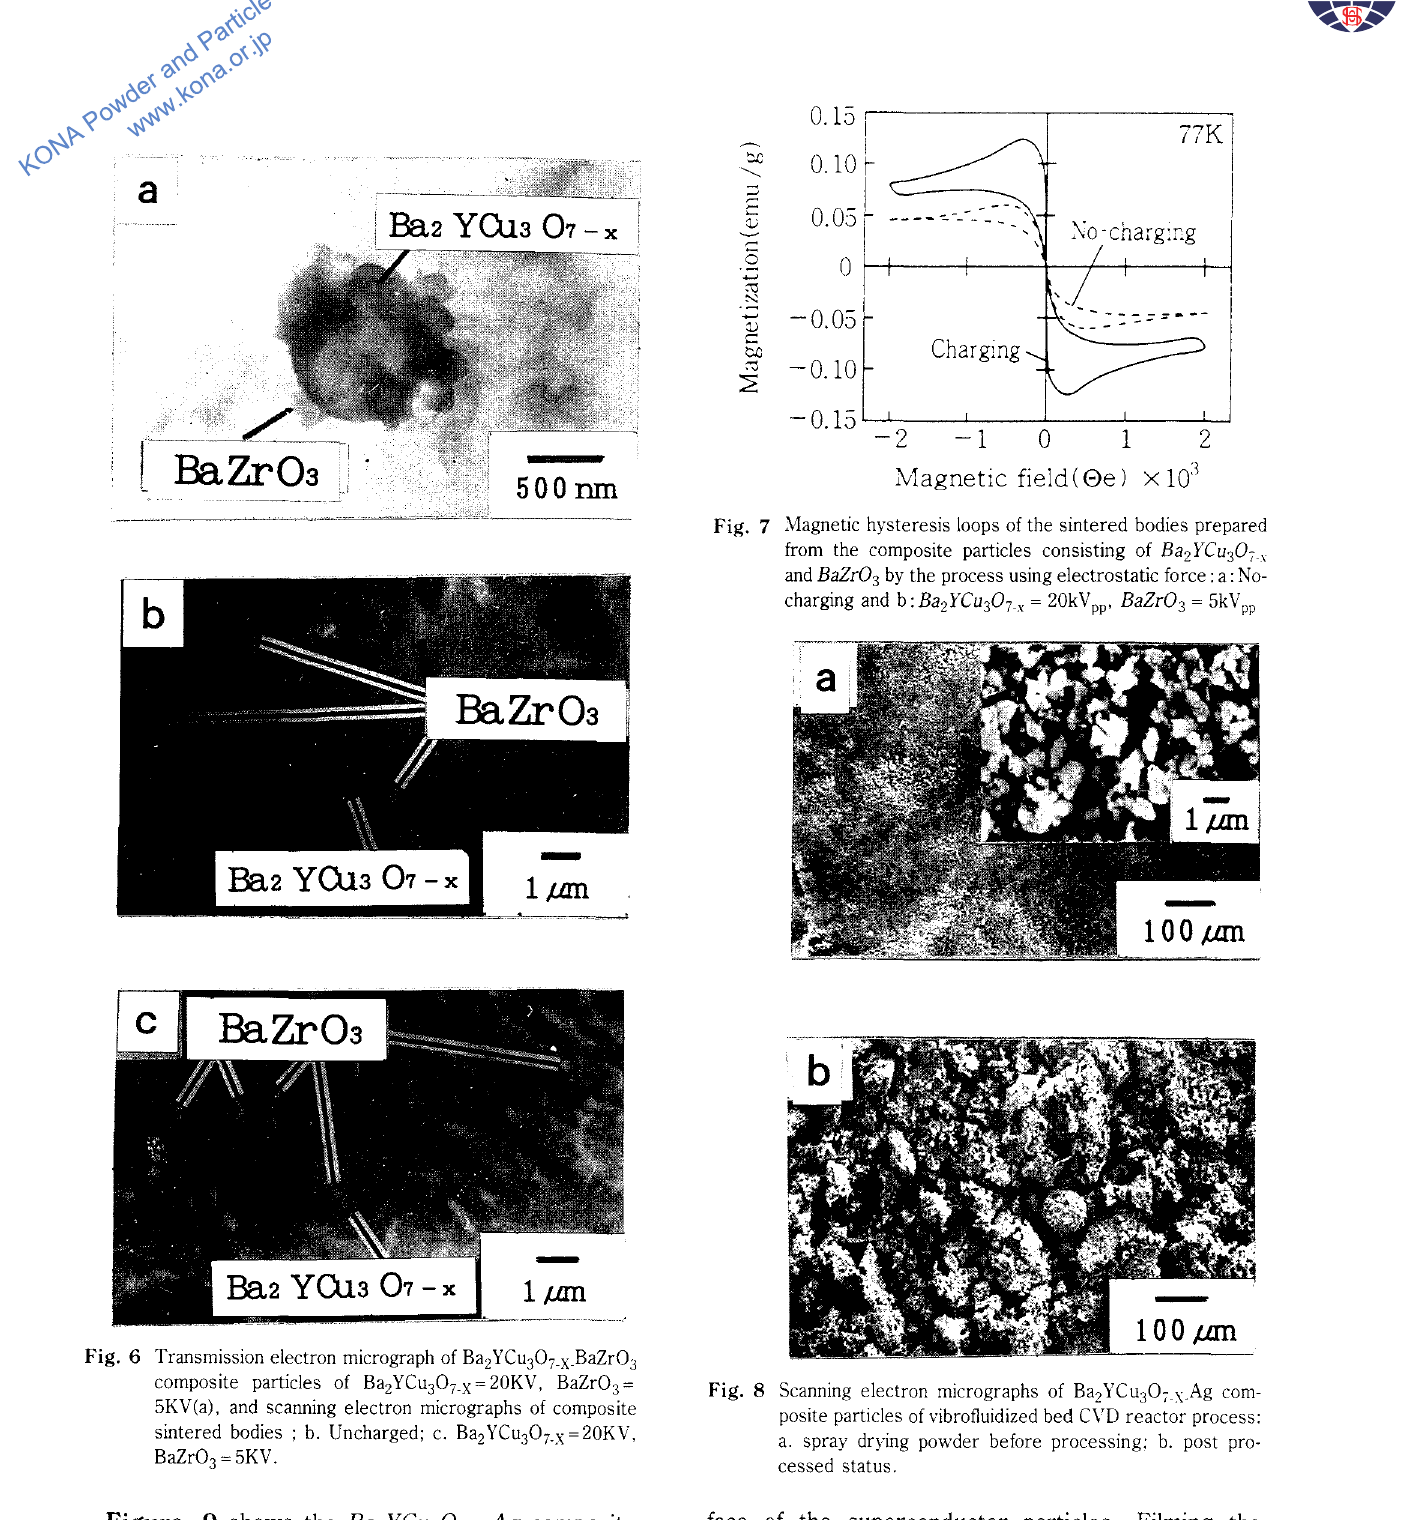
3 = Fig. 8 Scanning electron micrographs of Ba 2 YCu 3 0 7 _\_Ag com 3 posite particles of vibrofluidized bed C\'D reactor process: a. spray drying powder before processing; b. post pro cessed